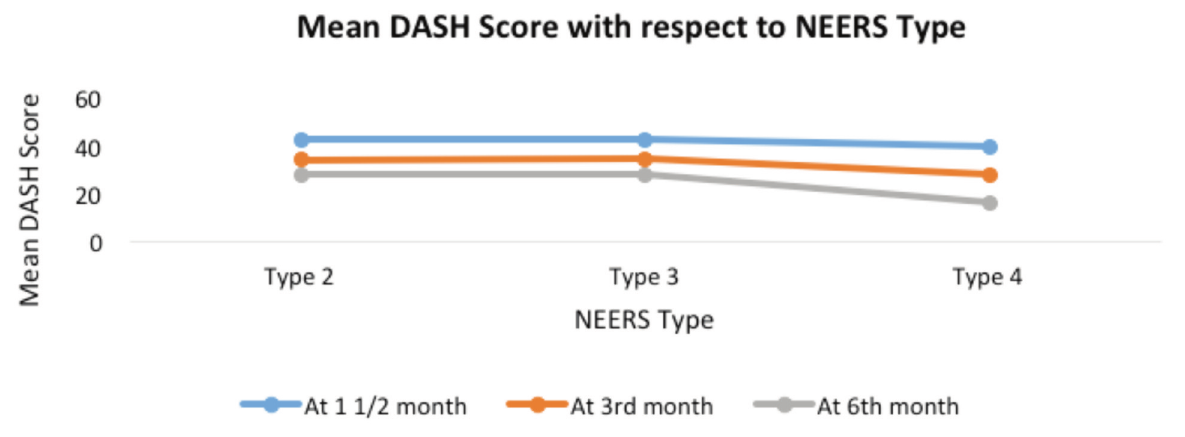
Mean DASH score vs type of Fig. 5: